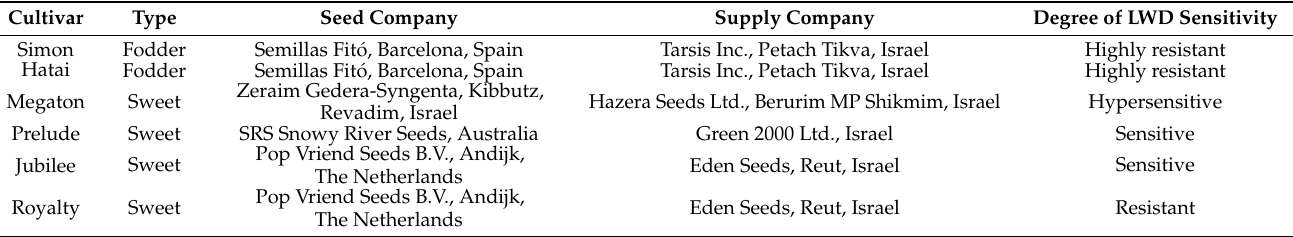
Table 1. Maize cultivars tested for endophytes